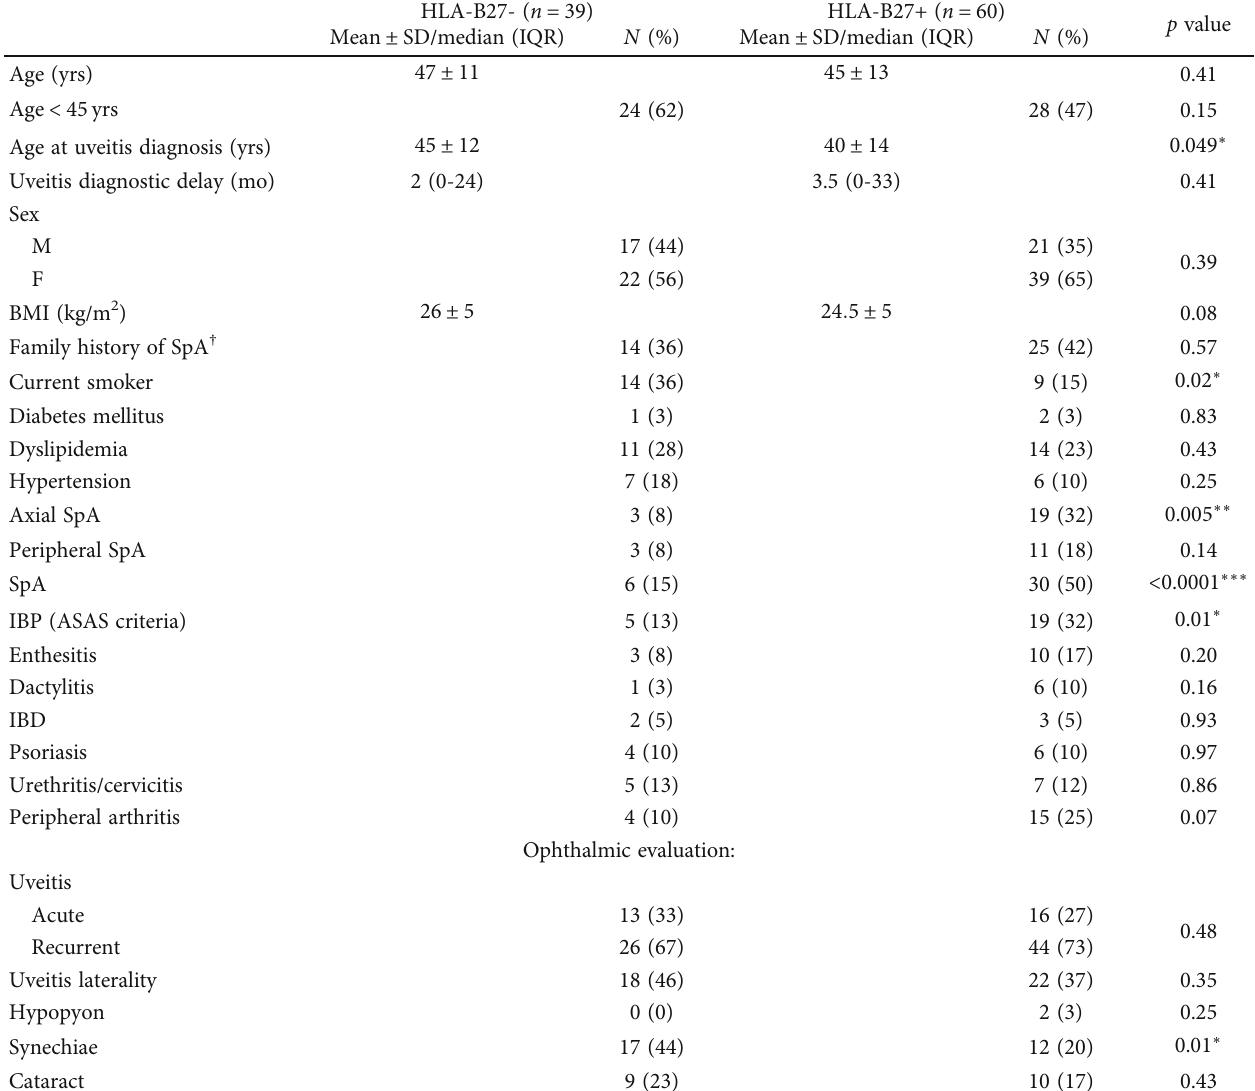
Table 5: Main characteristics of study population according to HLA-B27